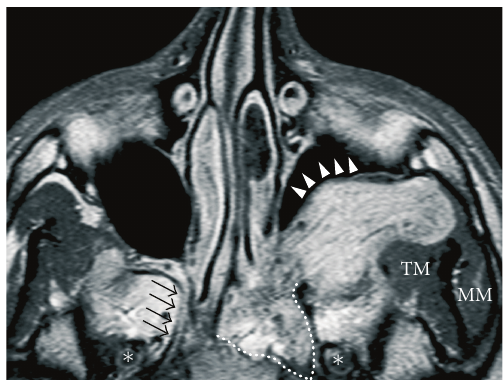
Figure 2: Axial contrast enhanced MRI: extensive JA with a typical pattern of spread into the cancellous bone of the basisphenoid along the vidian canal (white dotted line); on the contralateral side, black arrows indicate the right vidian nerve. Moreover, the lesion spreads deeply into the pterygomaxillary fossa toward the masticatory muscles, with anterior displacement of the posterior maxillary wall (white arrowheads). Asterisks indicate the foramen ovale bilaterally. TM: temporalis muscle; MM: masseter